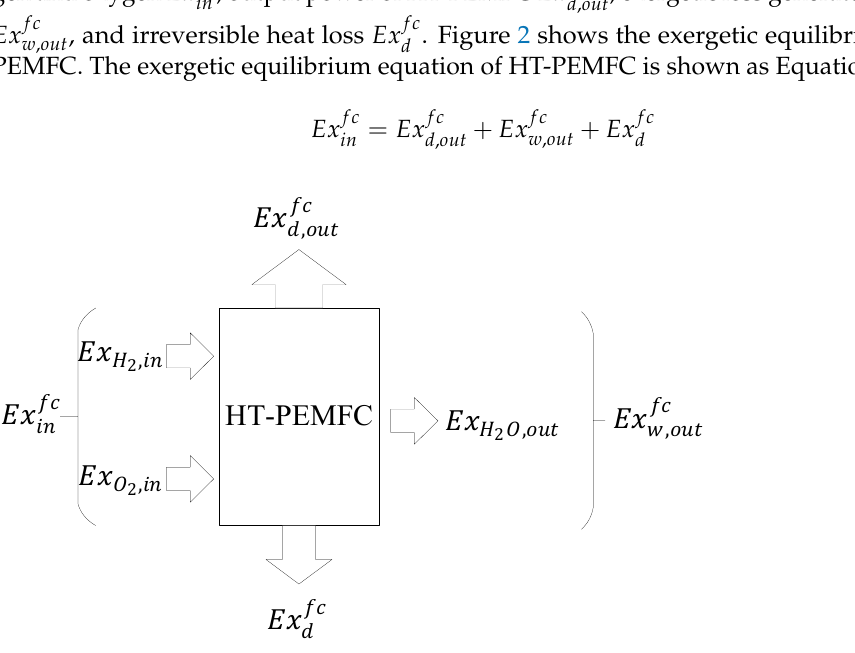
Figure 2. Exergetic equilibrium of the HT-PEMFC.